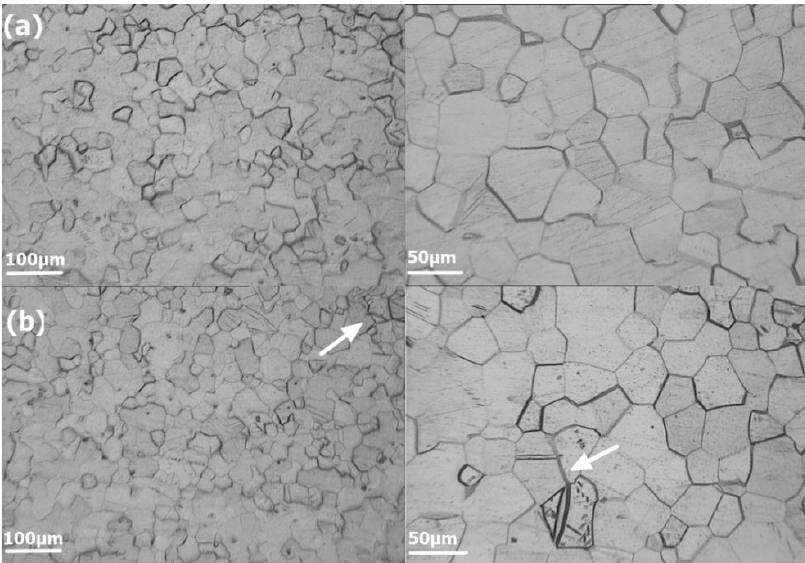
Figure 8. Metallographic figures of different prestrained samples after heat-treatment (500 °C, 40 min): ( a ) two percent prestrain with annealing; ( b ) five percent prestrain with annealing. Twins are indicated by white arrows in Figure 8 b .